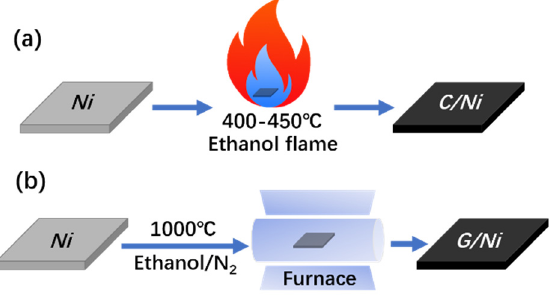
Figure 1. Schematic diagram of the coating process via: ( a ) flame deposition of carbon and ( b ) CVD of graphene coating. of graphene